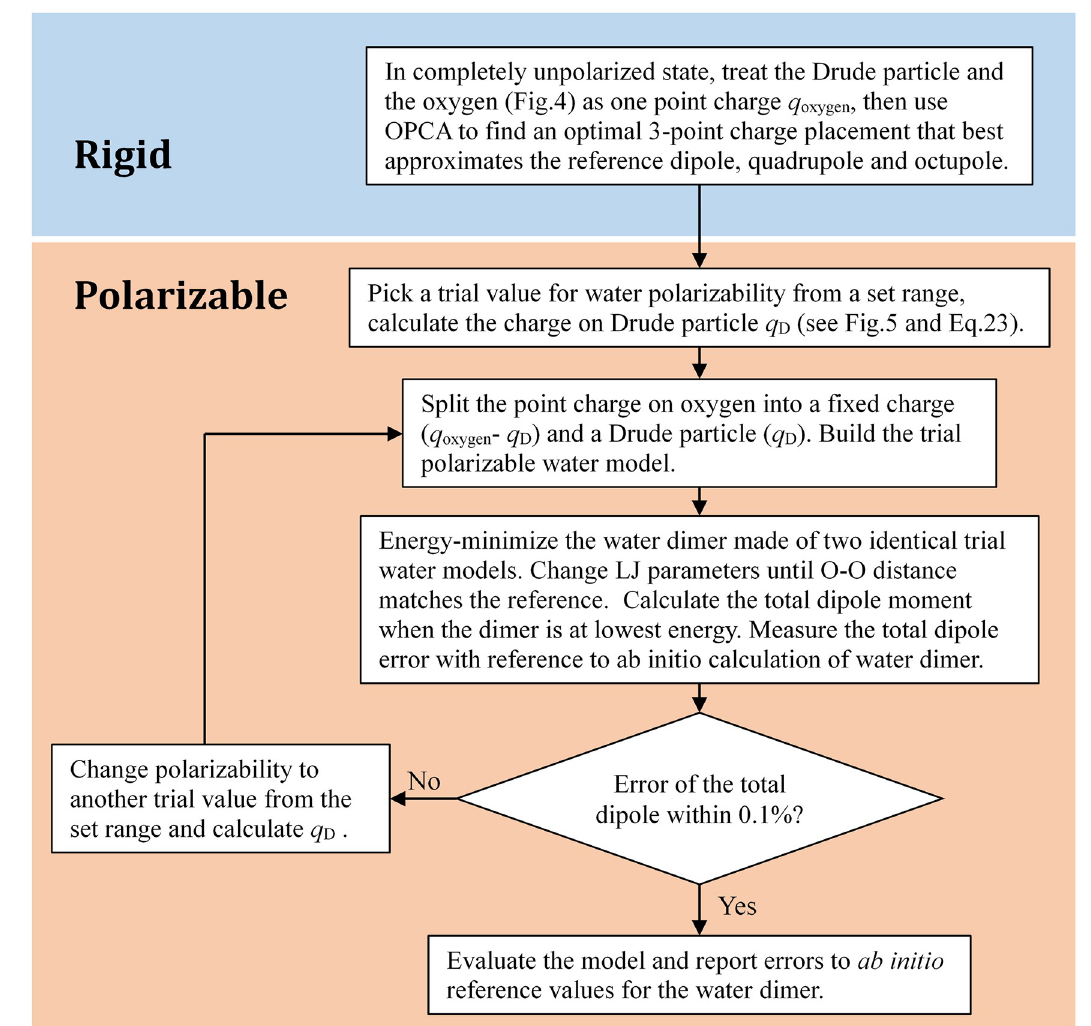
Fig 6. Flowchart: The process of building a polarizable Drude water